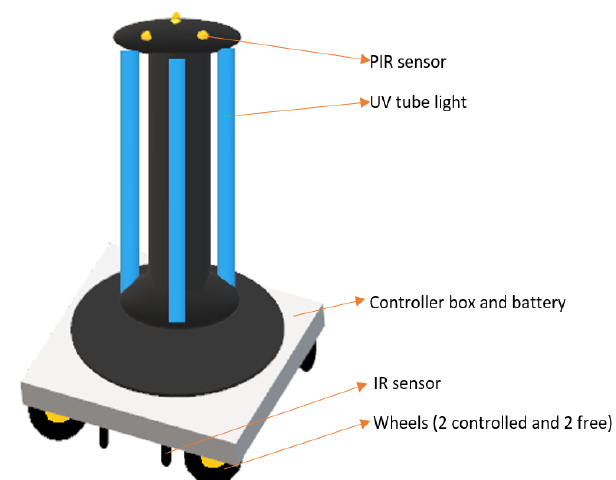
Figure 4. Design of UV